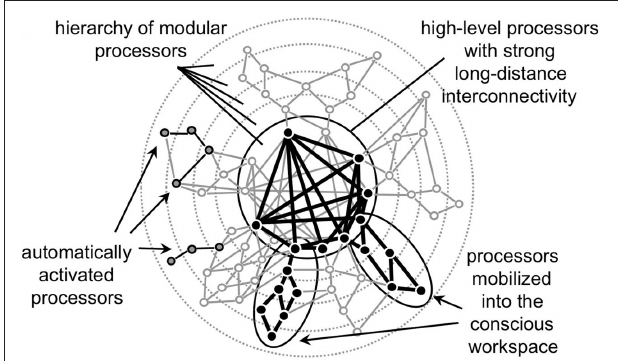
Figure 4 | Symbolic representation of the hierarchy of connections between competing brain processors, after Dehaene and Naccache (2001). Processors are mobilized into the workspace. As a counterpart, even if active, some others are kept out (repressed) of